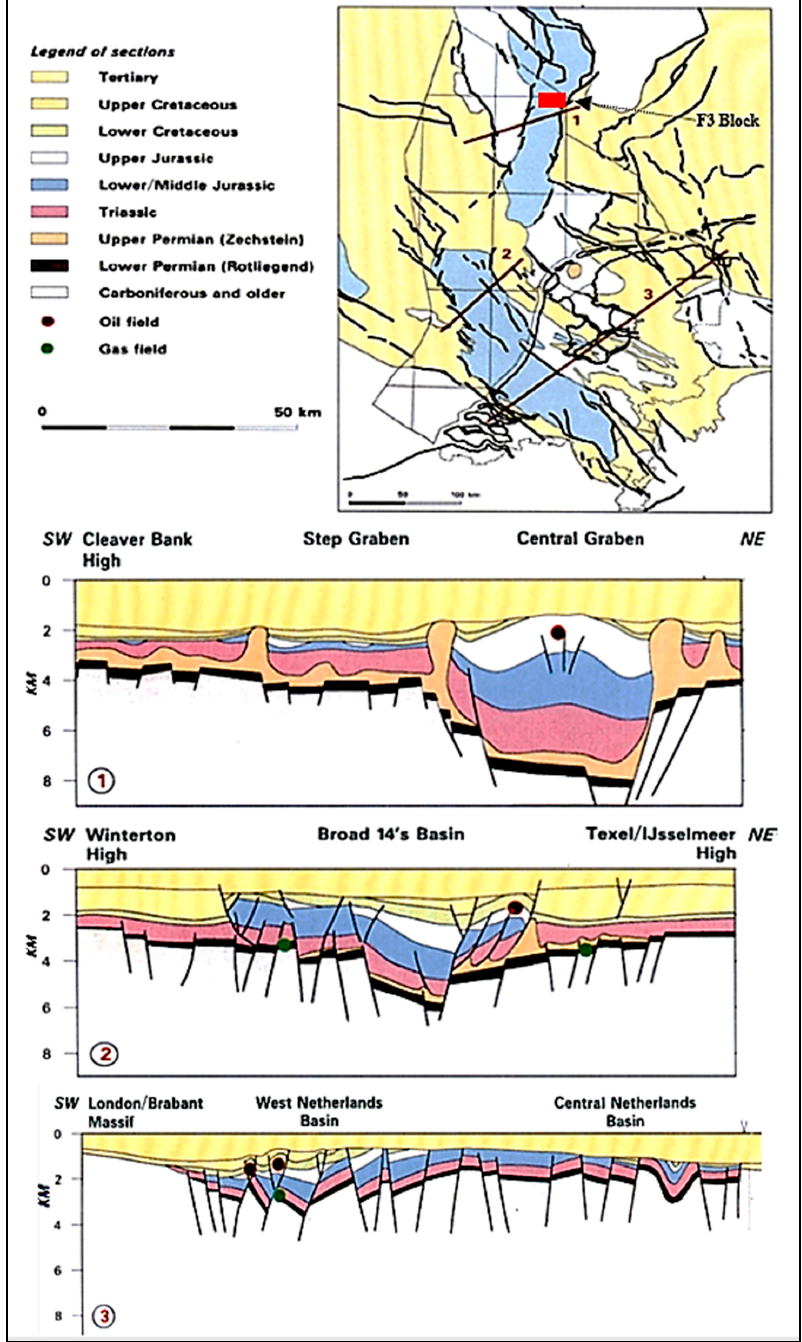
Figure 4. The tectonic framework and regional cross-section of the North Sea after Rondeel, Batjes and Nieuwenhuijs [40]. The red box indicates the F3 block (the study area). The Lower North Sea Group essentially consists of grey sands, sandstones, and clays and is a product of several small and large scale clastic sedimentation cycles in a marine setting at the edge of the North Sea Basin. The upper boundary of this group is characterized by unconformably overlying deposits of the Middle North Sea Group or younger units, while the lower boundary is characterized